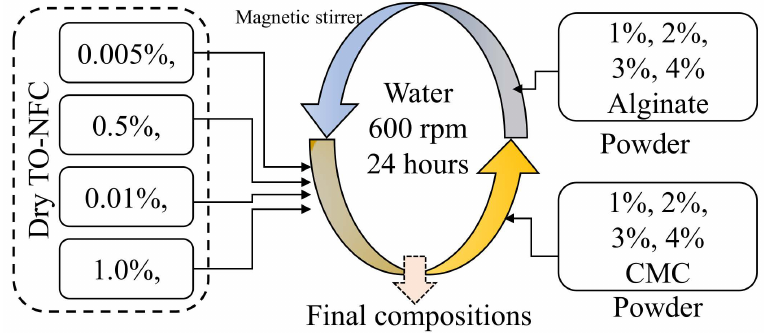
Figure 1. Schematic representation of the preparation of